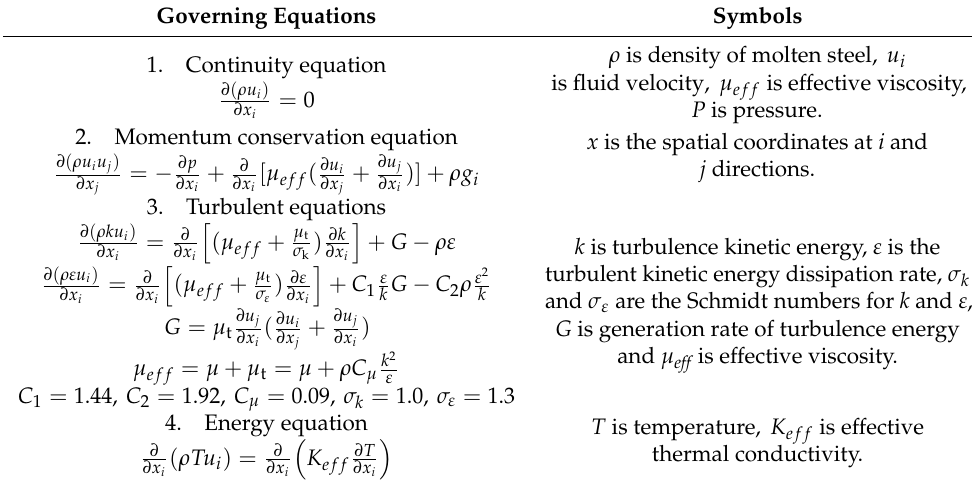
Table 4. Governing equations of the mathematical model.